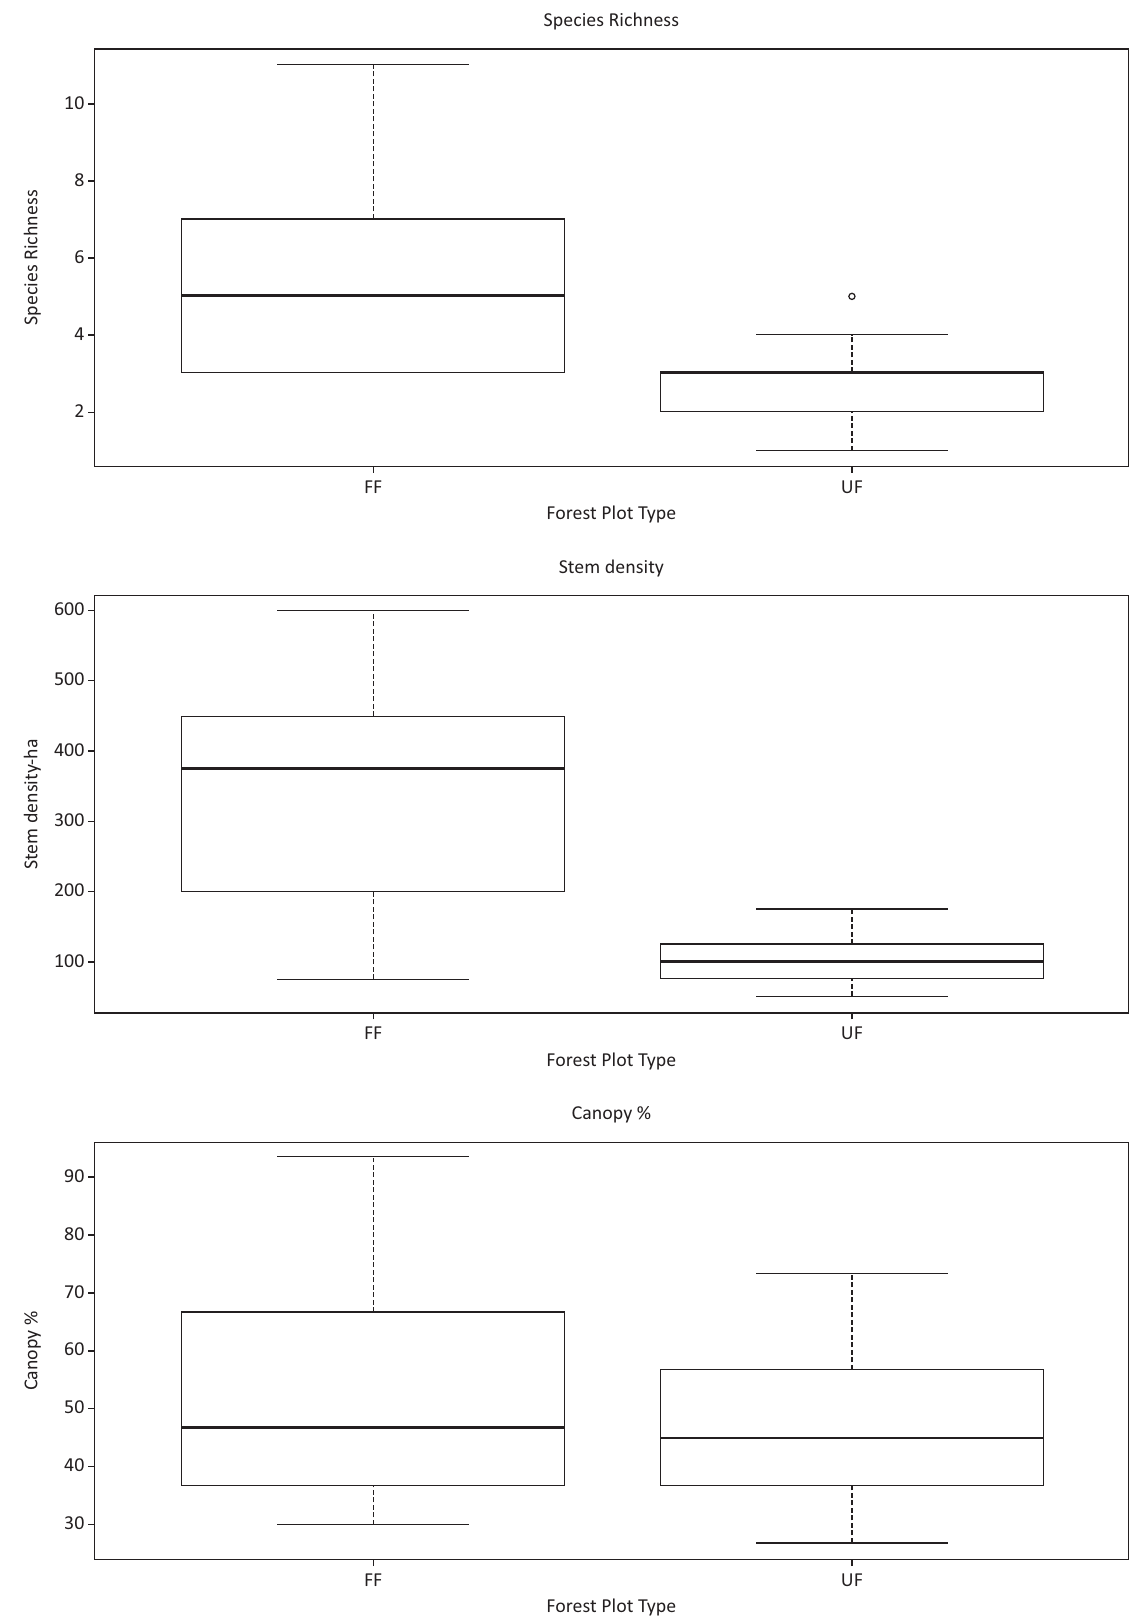
Figure 5. Paired student t‐test results for species richness (number of species per hectare; p = 0.02), stem density (num‐ ber of stems dbh ≥ 5cm per hectare; p ≤ 0.01), and canopy coverage (in %; p = 0.57) for 10 FF plots and 10 UF plots in Miami‐Dade County,